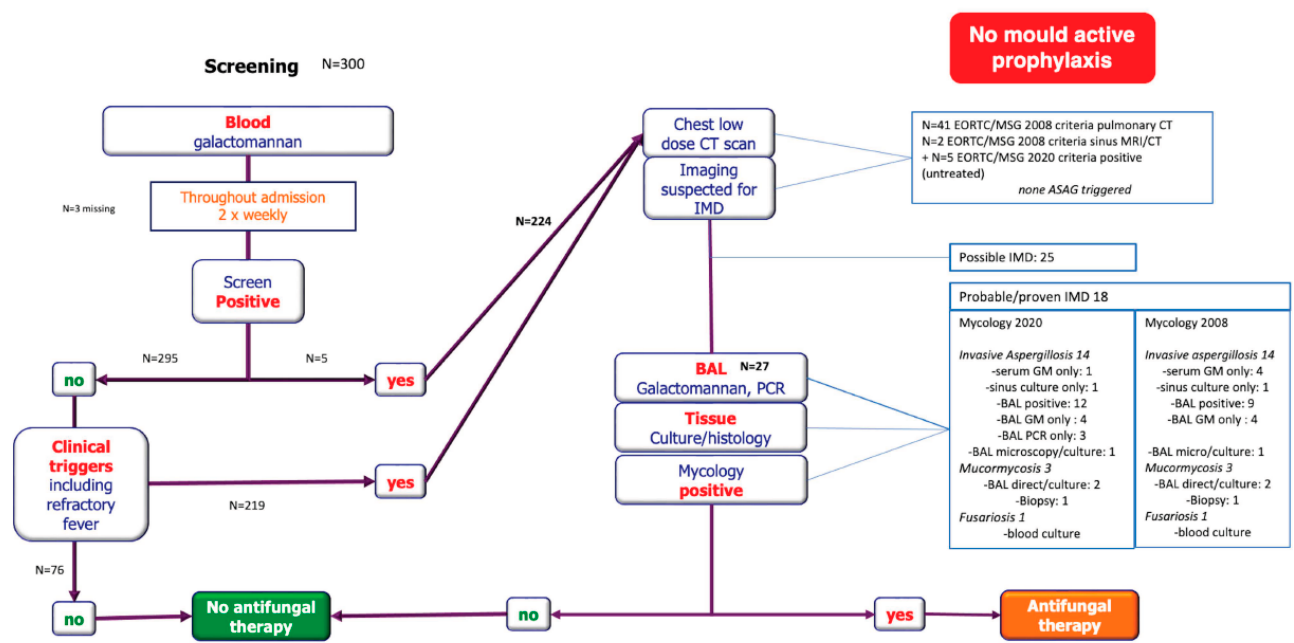
Figure 1. Radboudumc diagnostic-driven care pathway with stepwise overview of diagnostic testing and results. Positive diagnostic tests according to EORTC/MSG 2020 criteria except if stated otherwise.